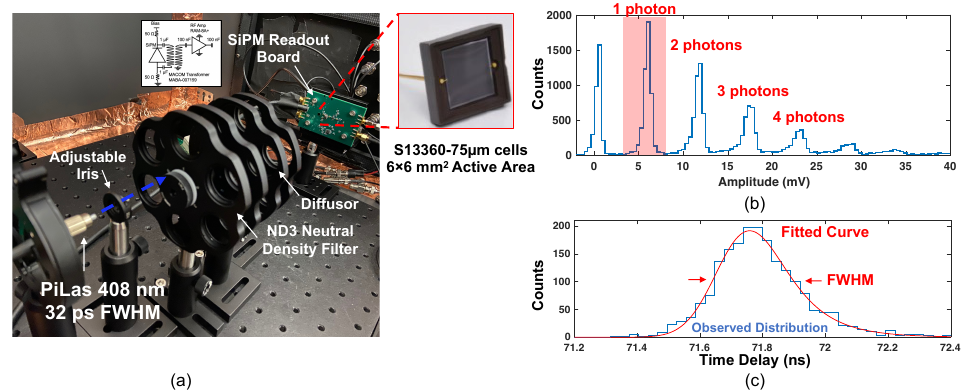
Figure 4. The experimental setup used to measure single photon time resolution with a fast laser is shown in ( a ). Waveforms from the detector readout shown in ( a ) were digitized and analyzed in post processing, where single photons in the detector were filtered, as illustrated in ( b ). An example histogram of time difference between the laser external triggering and the time pickoff on the SiPM waveforms is shown in ( c ), where the distribution is fit with a convolution of Gaussian and exponential curves, as outlined in